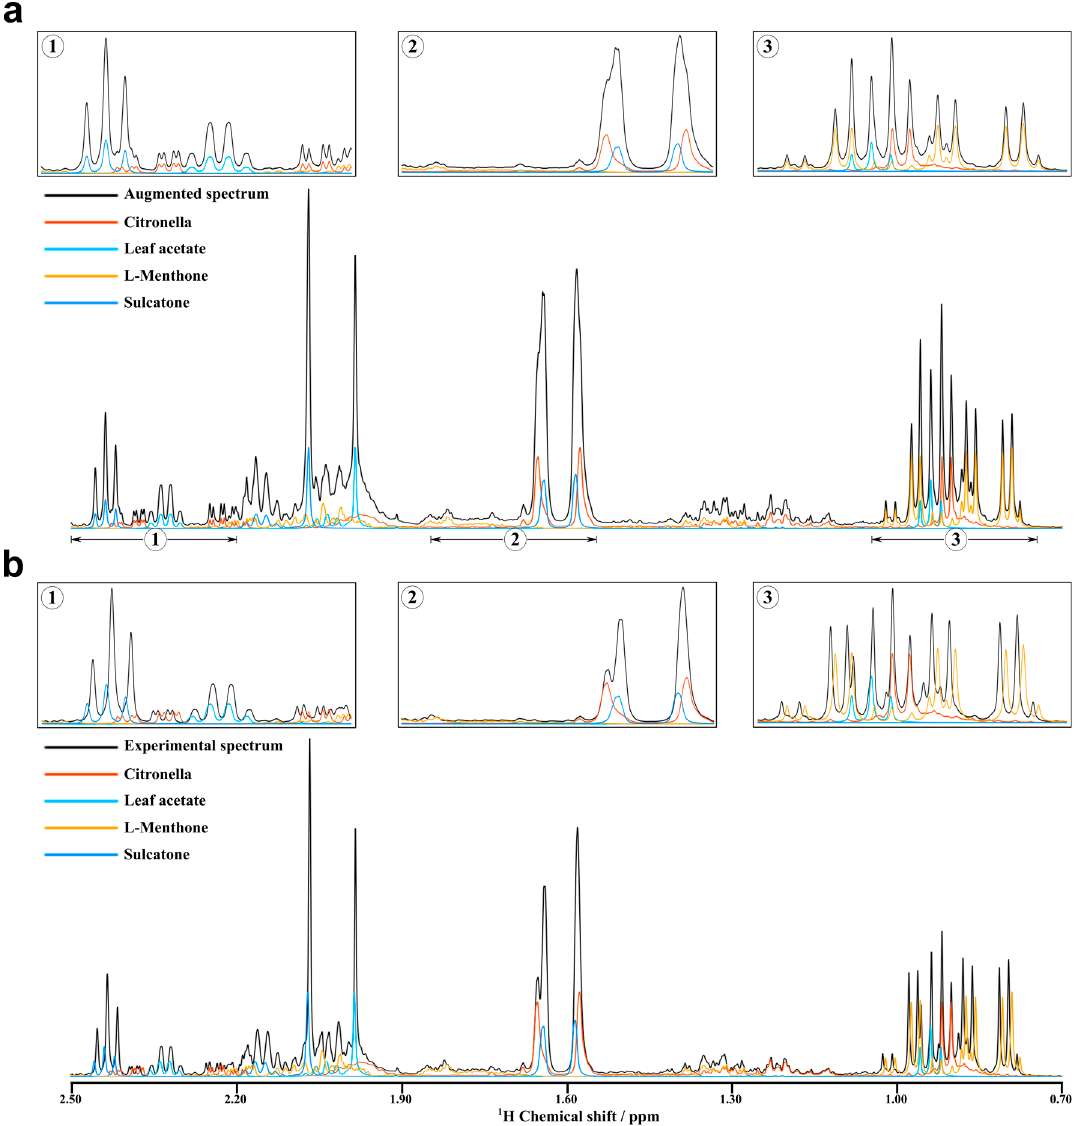
Figure 3. Augmented and experimental NMR spectra. ( a ) The spectrum of mixture obtained by data augmentation and its components spectra. ( b ) The experimental NMR spectra of the mixture and its components. ( 1 – 3 ) are the local zoomed-in views.